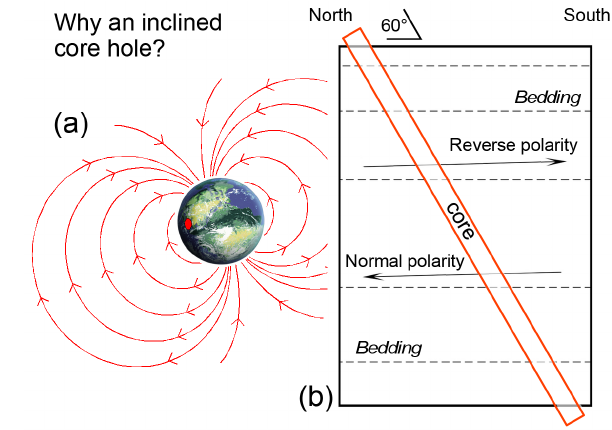
Figure 7. The nearly horizontal bedding in PFNP was used for orientation by inclining the corehole nominally 60 ◦ for 1A and 2A and 75 ◦ in approximate southerly directions (see Table 1). (a) Earth’s magnetic field line (normal polarity) with Earth with Tri- assic Pangea and location of Colorado Plateau (red dot) – note the field lines near horizontal near the Equator. (b) Diagram of inclined core hole at 60 ◦ with normal and reverse polarity field lines near horizontal due to low latitude position of the Colorado Plateau dur- ing the Triassic. The cores were intended to be split along the per- pendicular to the inclined core so that bedding is seen to dip 30 ◦ , for 1A and 2A, or 15 ◦ for 2B, relative to the long axis of the core (compare with Fig. 8).